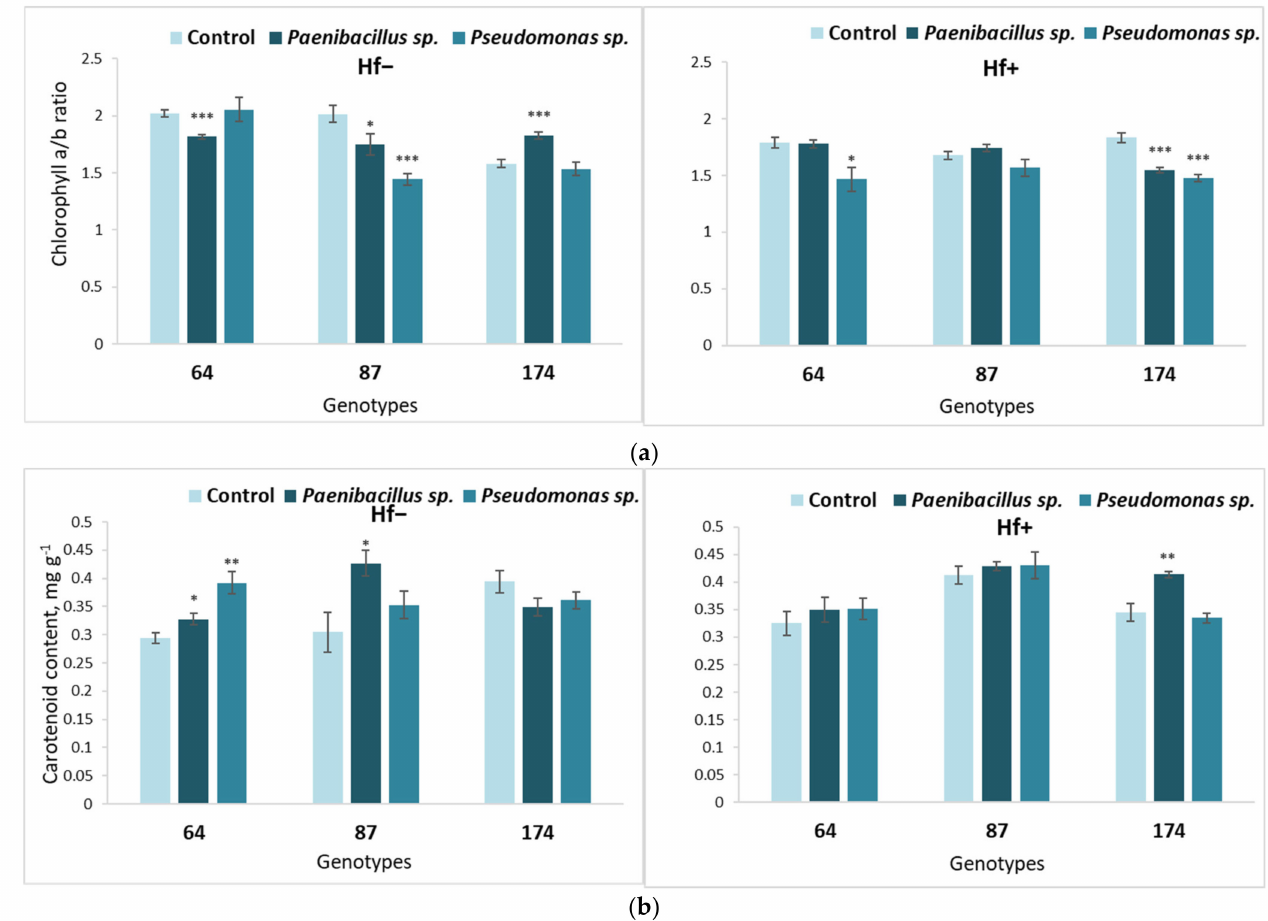
Figure 7. Average chlorophyll a/b ratio ( a ) and carotenoid content ( b ) in the leaves of different F. excelsior genotypes (64, 87 and 174), of which explants were first cultured on the nutrient medium inoculated with Paenibacillus sp. or Pseudomonas sp. bacteria, then transferred onto fresh nutrient medium, either sterile (‘Hf − ’) or inoculated with the fungus H. fraxineus (‘Hf+’). Statistically significant differences from the control variant, which was not treated with bacteria during the first culture stage, are indicated (for each genotype separately): * p < 0.05, ** p < 0.01, *** p <